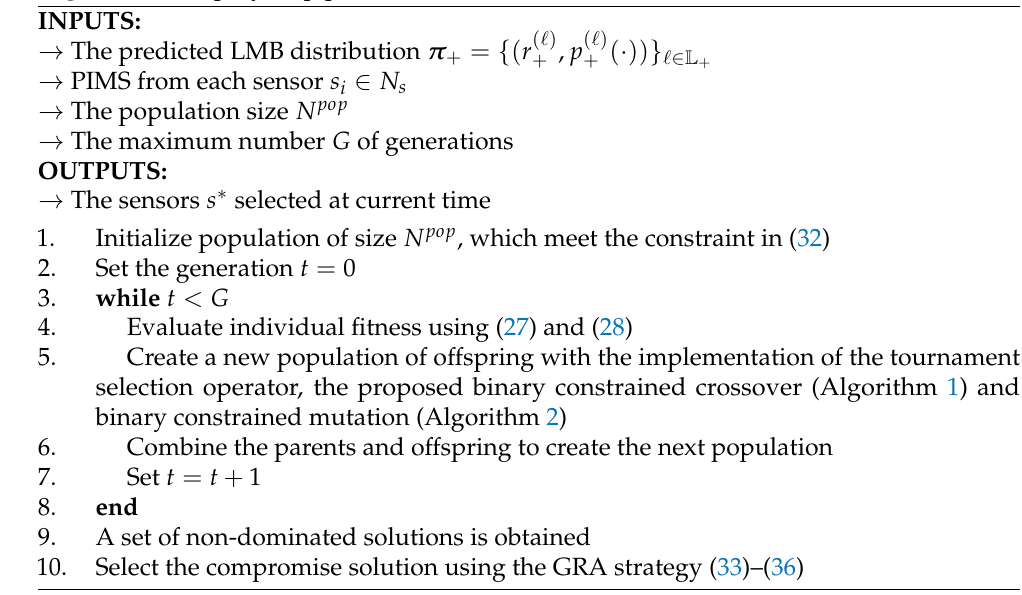
Algorithm 4 Step-by-step pseudocode for the EMOO-based sensor